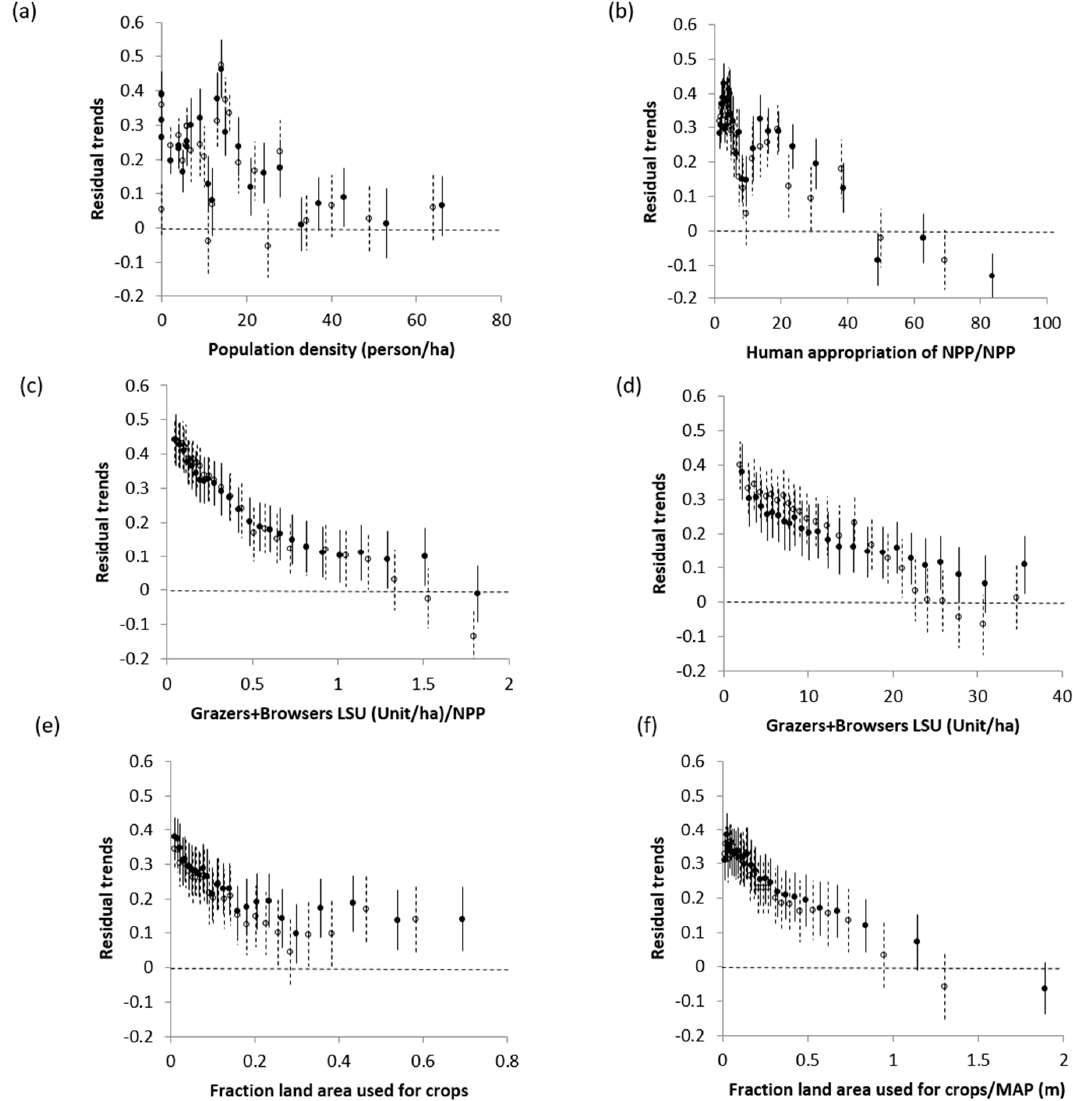
Figure 5. Mean RESTREND values (observed–potential) within groupings of: ( a ) population density (persons/ha); ( b ) percentage human appropriation of NPP (HANPP%); ( c ) livestock unit density (units/ha); ( d ) livestock unit density normalized by site productivity; ( e ) fraction land area used for crops; and ( f ) fraction land area used for crops normalized by mean annual precipitation. Filled circles are trends of the residuals where potential NDVI was obtained from OLS multivariate regression between NDVI and precipitation, specific humidity, and temperature. Open circles are trends of the residuals where potential NDVI was obtained from OLS multivariate regression between NDVI and precipitation, its seasonal variance, and skewness. Error bars are ±1 standard deviation around the mean. Dashed lines mark the zero RESTREND values.